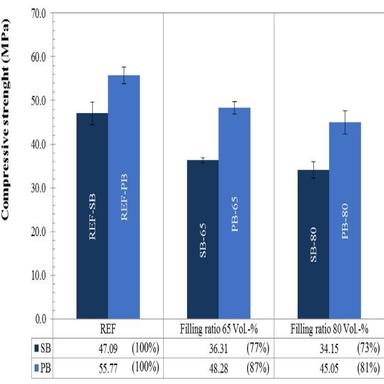
Comparing the compressive strengths, Rc, between PCM-RBA mortar mixtures with SB and PB RBAs. The vertical scatter indicators represent the range between the minimum and the maximum values.